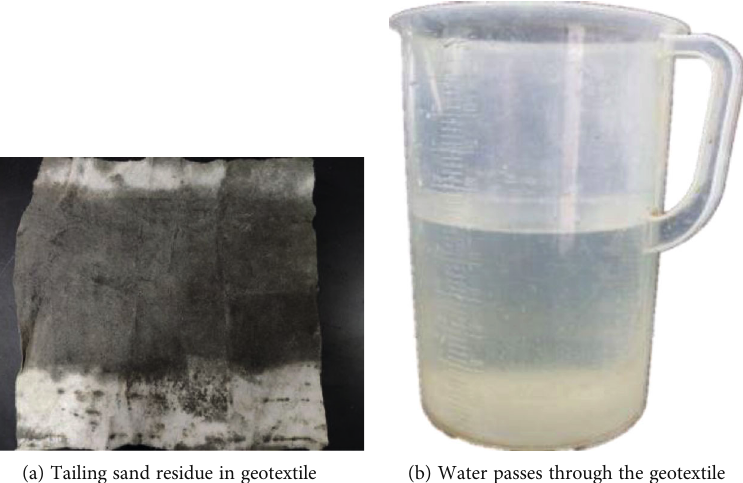
Figure 17: The mixture separates into tailing sand and clear